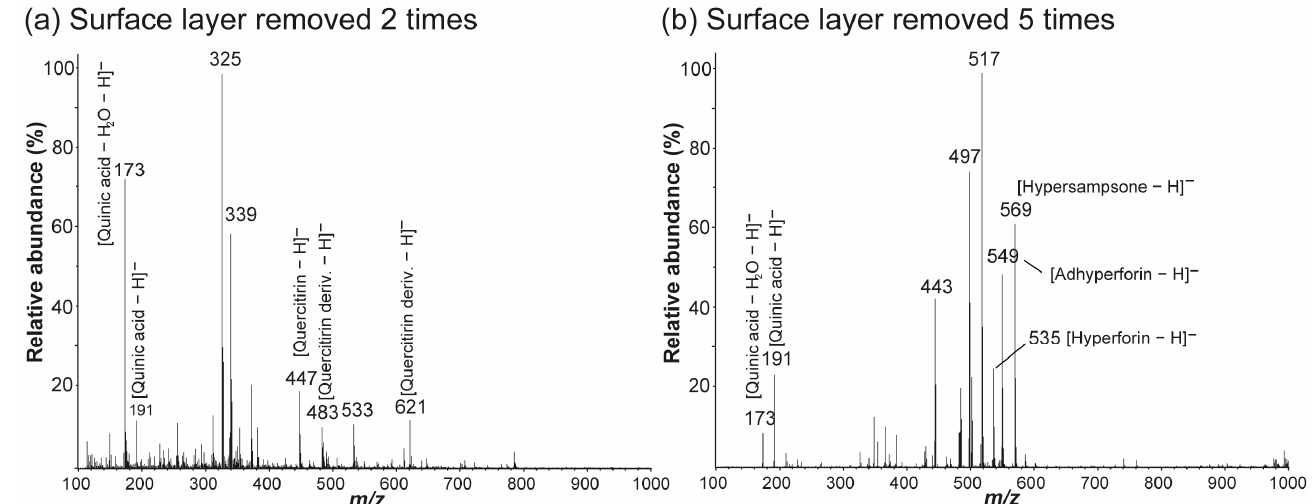
Figure 7. Nano-DESI mass spectra of the surface-layer-removed leaf samples in the negative ion mode. Mass spectra were acquired from the leaf surfaces whose surface layers were removed ( a ) two and ( b ) five times by polymeric gum Arabic film formation and detachment. The spraying solvent was EtOH. The abbreviation “deriv.” denotes “derivative”.